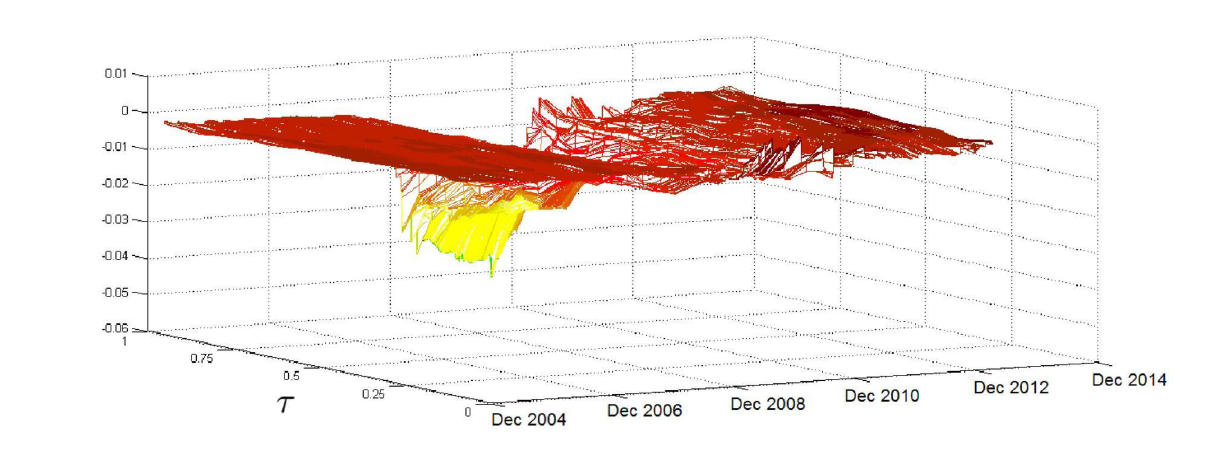
Figure 5. Rolling analysis for sp 500 t − 1